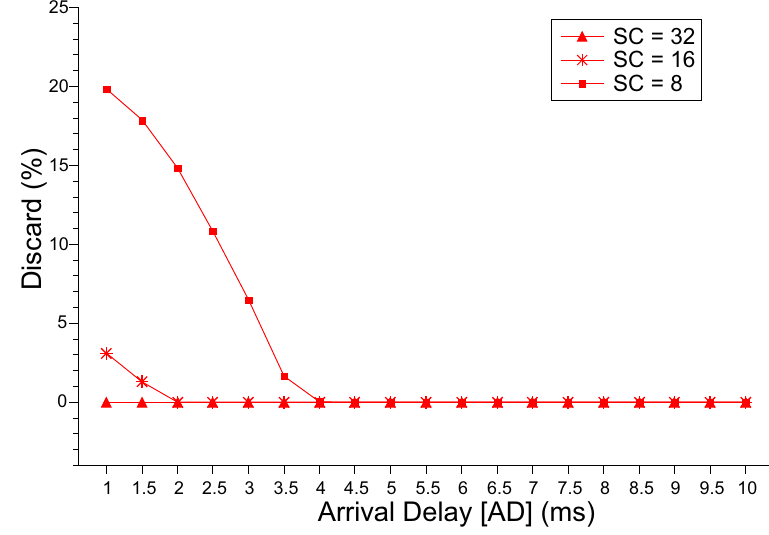
Figure 7. Discard